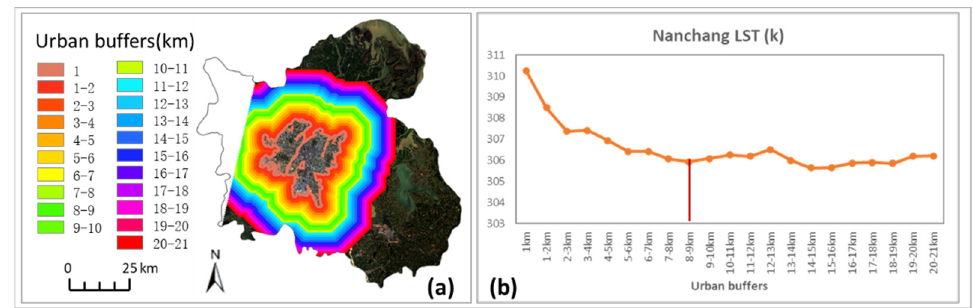
Figure 4. The urban heat radiation distance for Nanchang in 2017. ( a ) The spatial location for each buffer in Nanchang. ( b ) The average LST for each buffer in Nanchang.